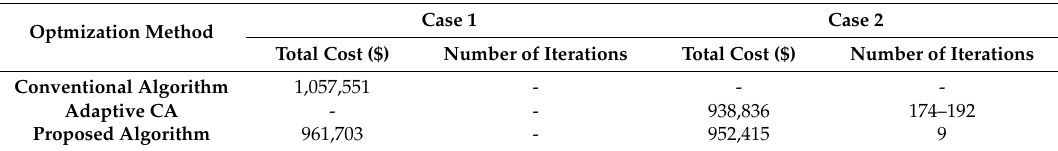
Table 5. Optimal network cost obtained by different methods for the two